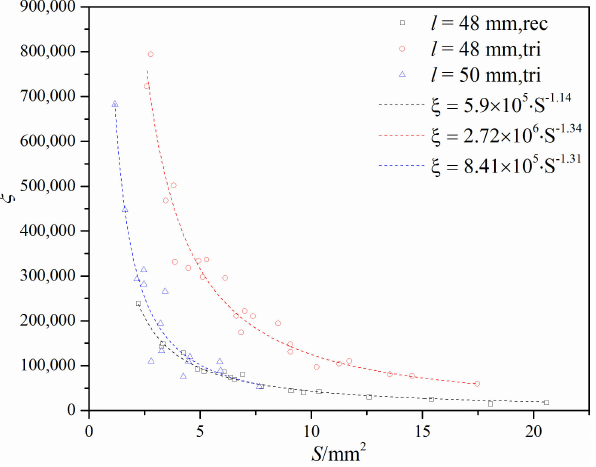
Figure 15. Loss coefficient under different flow cross-areas and different gap